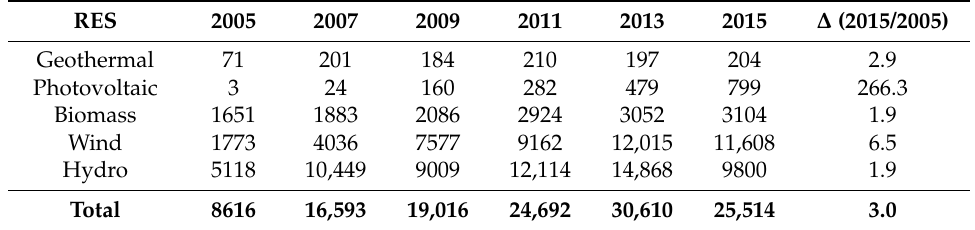
Table 6. Annual renewable power production (GWh) in Portugal and corresponding variation in the 2005–2015 decade